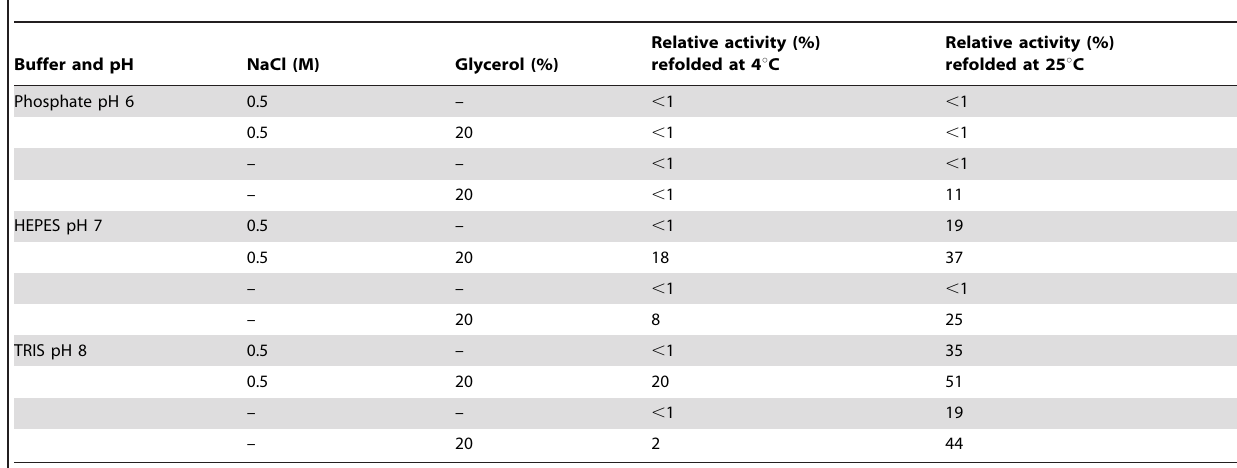
Table 3. Ta AlDH enzyme activity after refolding purified Ta AlDH inclusion bodies by dilution under different renaturing